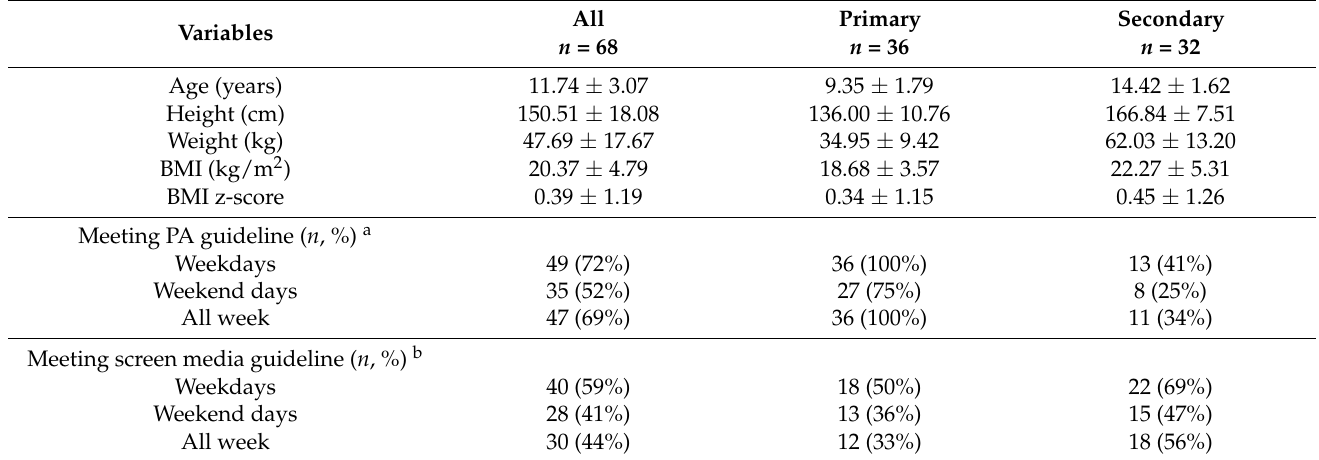
Table 1. Characteristics of youths with autism spectrum disorder